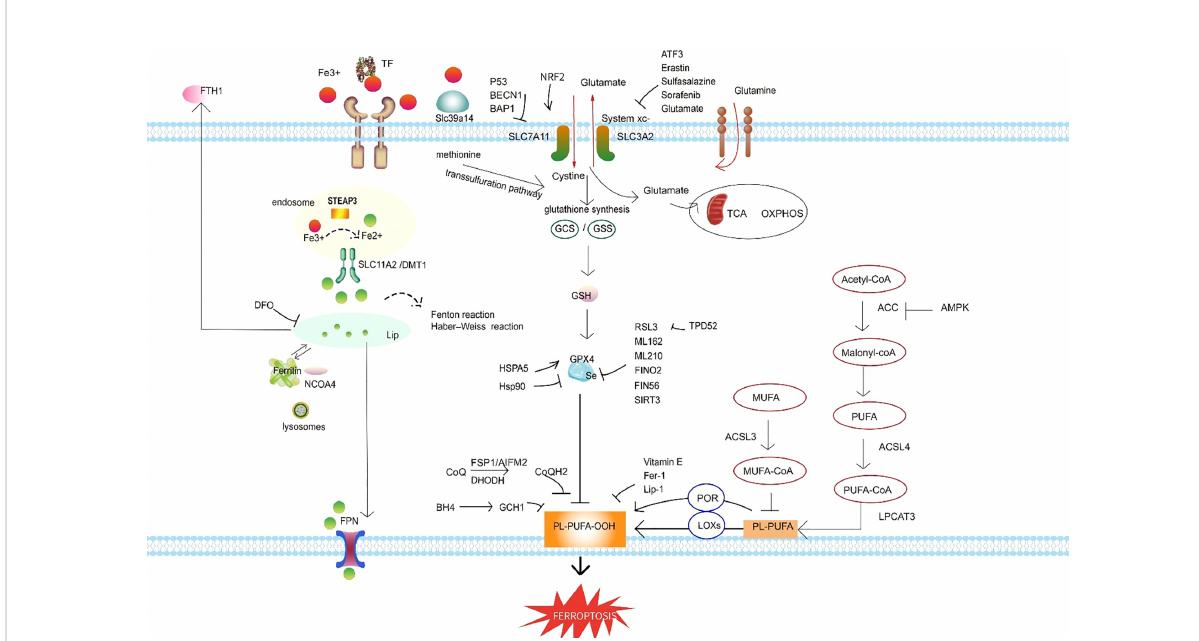
FIGURE 3 Ferroptosis regulatory pathways. The regulatory pathways of ferroptosis can be roughly classi fi ed into three types. The fi rst involves iron metabolism, including the regulation of ferritin degradation by NCOA4. The second is the GSH/GPX4 pathway, which includes system xc inhibition, the transsulfuration pathway, and the glutamine pathway. The third is lipid metabolism, including ACSL4, ACSL3, and LPCAT3, which are related to lipid regulation and ferroptosis. In addition, FSP1 inhibits ferroptosis independently of GSH, and the BH4 – GCH1 axis effectively inhibits lipid peroxidation and thereby defends against ferroptosis. Abbreviations: TF, transferrin; FTH1, ferritin heavy chain 1; DFO, defetoxamine; LIP, labile iron pool; NCOA4, nuclear receptor coactivator 4; FPN, ferroportin; SLC11A2/DMT1, divalent metal transporter 1; STEAP3, six- transmembrane epithelial antigen of prostate 3; NRF2, NF-E2 – related factor 2; SLC7A11, solute carrier family 7 member 11; SLC3A2, solute carrier family 3 member 2; system xc-, the cystine/glutamate antiporter system; Slc39a14, the zinc transporter Zip14; BECN1, beclin 1; BAP1, BRCA-1 – associated protein; ATF3, recombinant activating transcription factor 3; GCS, glutamylcysteine synthetase; GSS, recombinant glutathione synthetase; TCA, tricarboxylic acid; OXPHOS, oxidative phosphorylation; GPX4, glutathione peroxidase 4; GSH, glutathione; HSPA5, heat shock protein A5; HSP90, heat shock protein 90; RSL3, RAS-selective-lethal-3; FINO 2 , an endoperoxide-containing 1,2-dioxolane; FIN56, ferroptosis-inducing 56; SIRT3, sirtuin 3; TPD52, tumor protein D52; Fer-1, ferrostatin-1; Lip-1, liproxstatin-1; FSP1, ferroptosis suppressor protein 1; AIFM2, apoptosis-inducing factor mitochondria-associated 2; BH4, tetrahydrobiopterin; GCH1, GTP cyclohydrolase-1; PL-PUFA-OOH, lipid peroxides; POR, NADPH-cytochrome P450 reductase; LOXs, lipoxygenases; PUFA, polyunsaturated fatty acid; MUFA, monounsaturated fatty acid; PL-PUFA, phospholipid-bound polyunsaturated fatty acids; ACSL4, acyl-coenzyme A synthetase long-chain family member 4; LPCAT3, lysophosphatidylcholine acyltransferase 3; ACC, acetyl CoA carboxylase; AMPK, AMP-activated protein